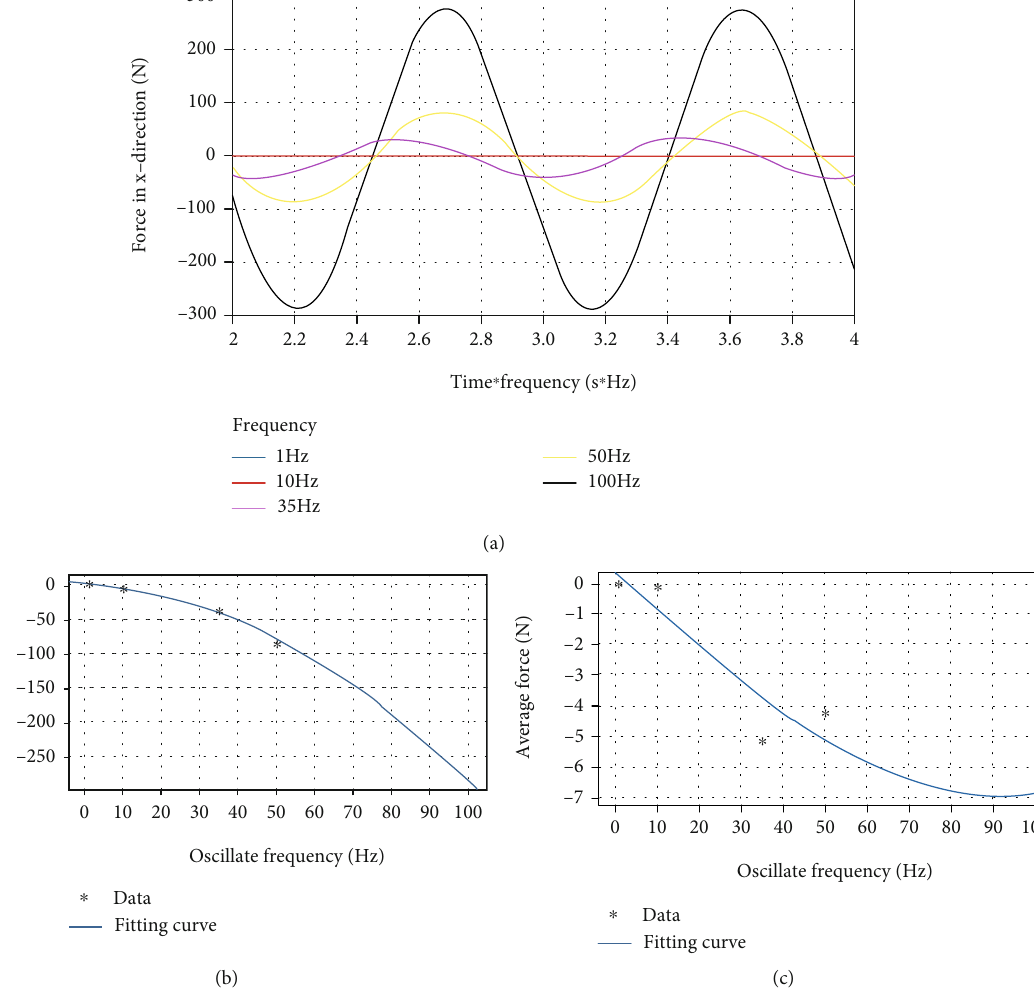
Figure 10: (a) x -direction force on the dorsal fi n at di ff erent frequencies. (b) The relationship between amplitude of force and frequency. (c) The relationship between average value of force and Table 4: x -direction force parameter values of the dorsal fi n at di ff erent frequencies. Parameter